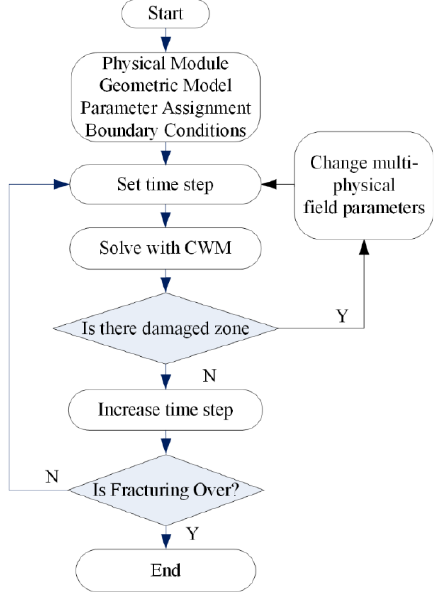
Figure 1. Coupling relations of different physical fields.